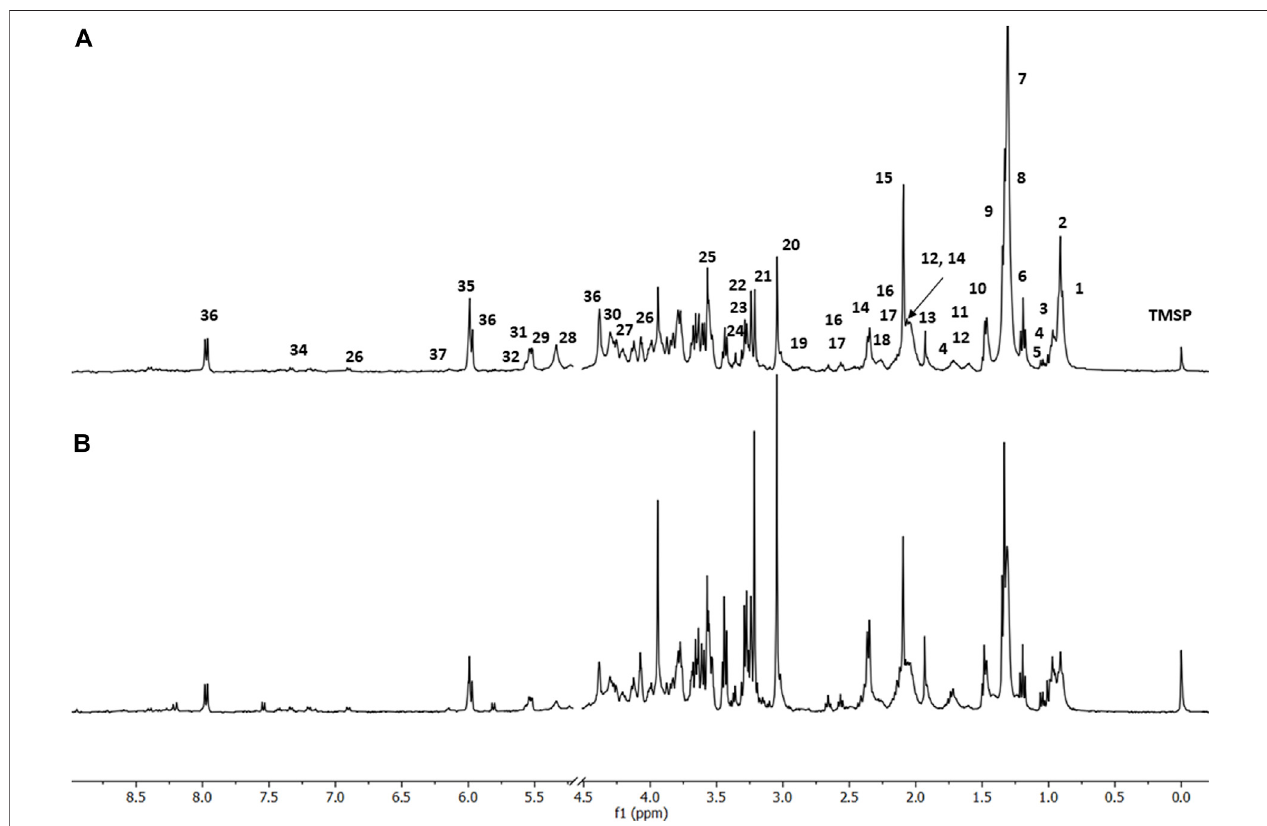
FIGURE 2 | HR-MAS spectra showing: (A) 1 H-NMR CPMG of fi broblast cells L929, with the exclusion of HDO, 4.80 ppm, (B) 1 H-NMR CPMG of fi broblast cells L929 treated with the AgNP@HST. Spectra were acquired with Bruker AVANCE III 400 MHz at 25 ° C. For the metabolites ’ assignments, see Supplementary Tables S1, S2